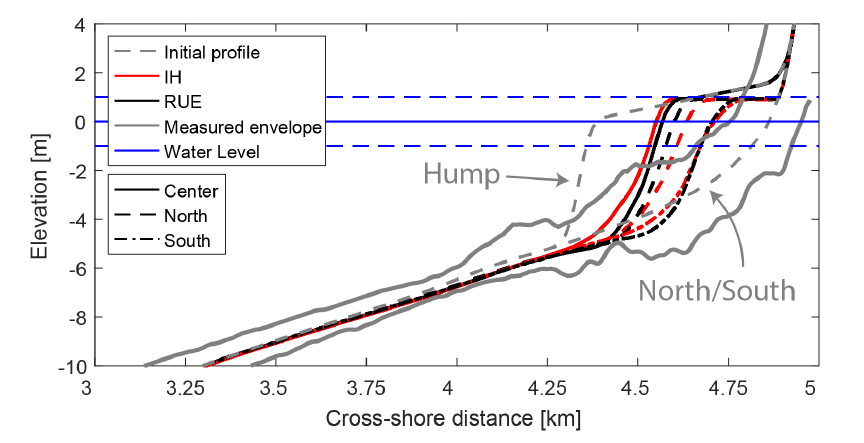
Figure 10. Cross-shore profiles over the hump and adjacent areas at Katwijk after 10 morphological years. Center presents the hump area while North and South are the adjacent areas from the hump (see Figure 1). Measure profile envelope (solid lines) and initial model bed levels (dashed lines) are depicted in